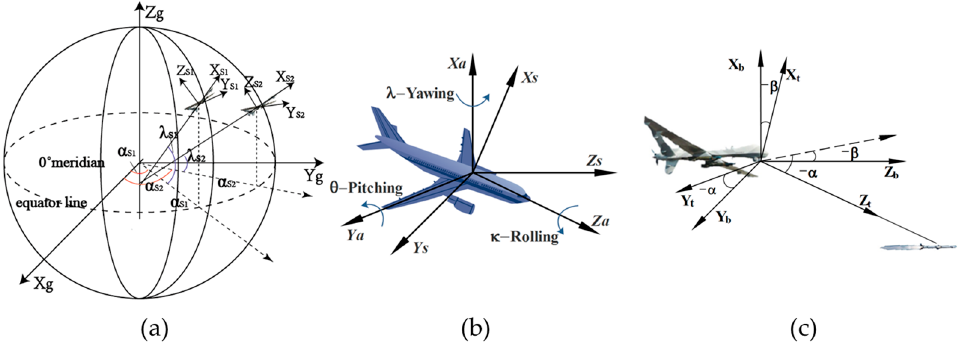
Figure 4. Definition of coordinate systems and their relations. ( a ) correlation diagram of terrestrial rectangular coordinate and geographic coordinate; ( b ) correlation diagram of geographic coordinateand UAV coordinate; ( c ) correlation diagram of UAV coordinate and camera coordinate.